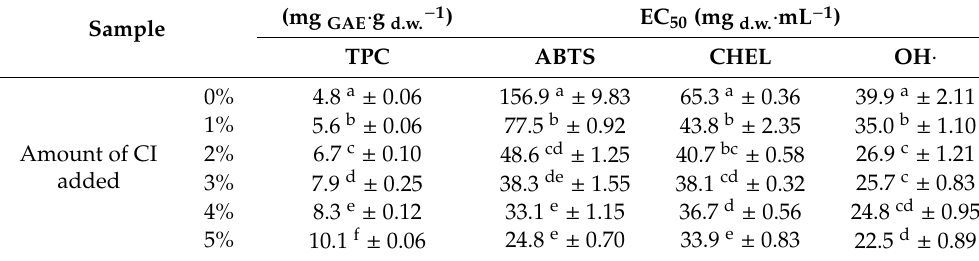
Table 3. Total phenolic content and antioxidant activity of bread supplemented with Cistus incanus L. (CI).